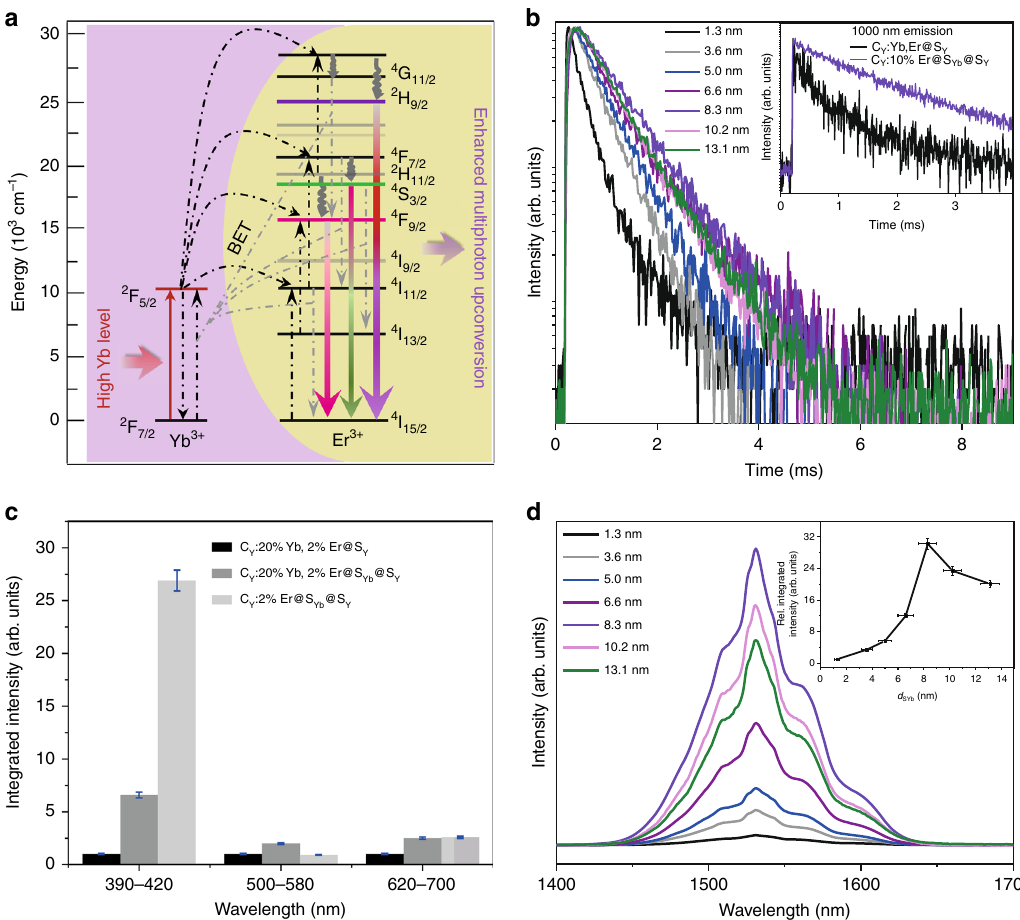
Fig. 4 Ef fi cient interfacial energy transfer in trilayered nanoparticles. a Simpli fi ed energy-level diagram shows enhanced multiphoton upconversion from Yb 3 + to Er 3 + in the C Y :10% Er@S Yb @S Y core-shell-shell nanoparticles ( d SYb ≥ 3.2 nm, d SY ≥ 2.0 nm). b Luminescence decay curves of Er 3 + emission at 407 nm for C Y :10% Er@S Yb @S Y nanoparticles with d SYb increasing from 1.3 to 13.1 nm ( d SY = 2.0 – 2.7 nm). Inset shows the decay curves of Yb 3 + emission for the as-synthesized C Y :10% Er@S Yb @S Y core-shell-shell ( d SYb = 8.3 ± 0.7 nm) and C Y :20% Yb, 2% Er@S Y core-shell nanoparticles ( d SY = 10.5 ± 0.8 nm). c Relative integrated UCL intensity of 2% Er 3 + -doped UCNPs (for trilayered structure, d SYb = 8.3 ± 0.7 nm, d SY = 2.3 ± 0.1 nm; for core-shell structure, d SY = 10.5 ± 0.8 nm). d NIR downshifting luminescence spectra and the relative integrated intensities (inset) for the C Y :10% Er@S Yb @S Y nanoparticles with varying NaYbF 4 shell thickness ( d SY = 2.0 – 2.7 nm). The error bars in ( c ) and ( d ) (inset) represent the standard deviation of three trials. Source data are provided as a Source Data fi